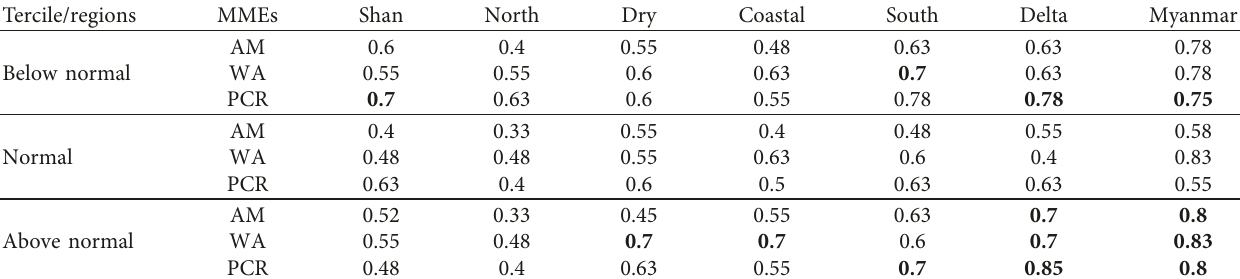
Table 3: ROC scores for three tercile categories over the six identified climate zones for the three MME schemes. Tercile/regions MMEs Shan North Dry Coastal South Delta Myanmar AM 0.6 0.4 0.55 0.48 Below normal